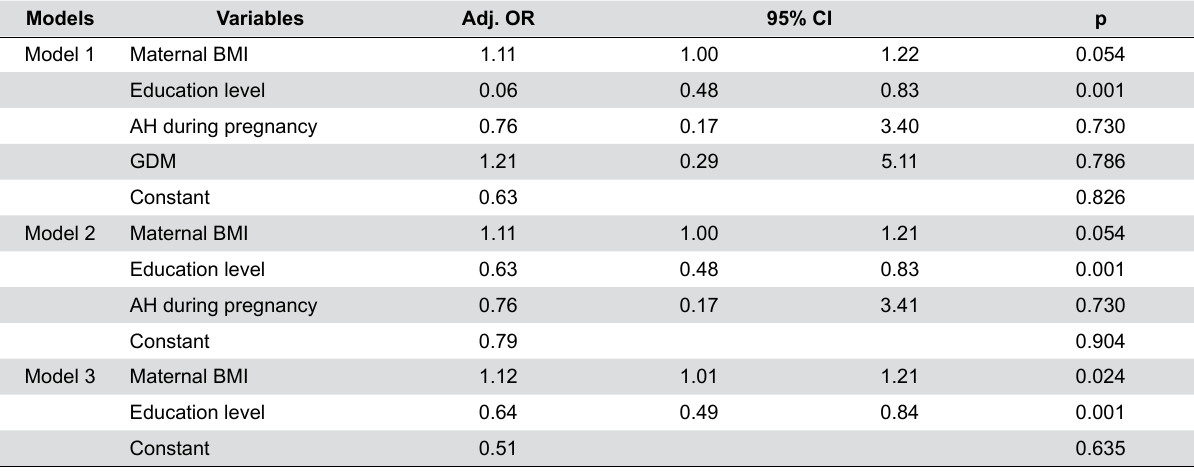
Table 2- Binary logistic regression model showing the independent variables associated with periodontitis during the third trimester of pregnancy